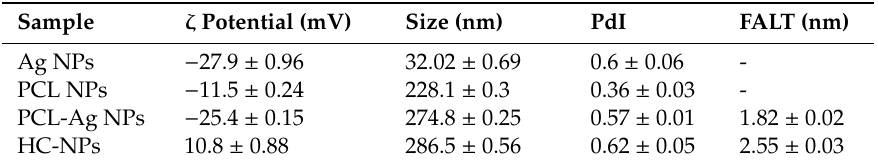
Table 1. Physicochemical characterization of di ff erent nanoparticle (NP) formulations. Representative measurements of three di ff erent sets of data have been reported ( P -values < 0.05). HC-NPs: hybrid clustered nanoparticles, FALT: fixed aqueous layer thickness, PdI: Polydispersion